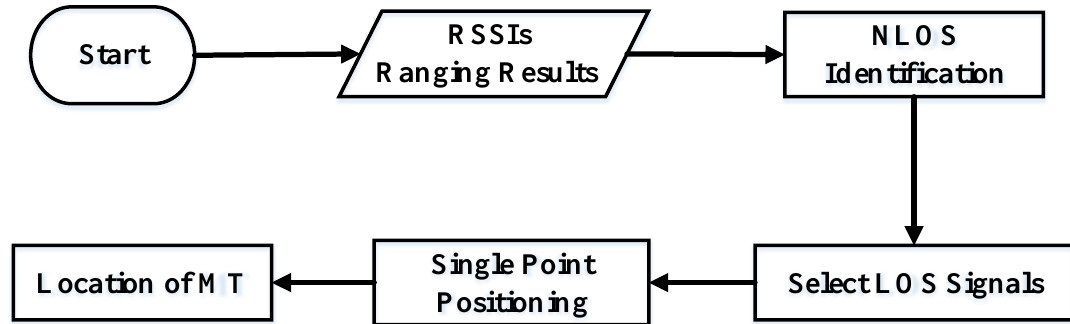
Figure 2. Flow chart of the proposed positioning method. RSSIs, received signal strength indicators; NLOS, non-line-of-sight; LOS, line-of-sight; MT, mobile terminal.